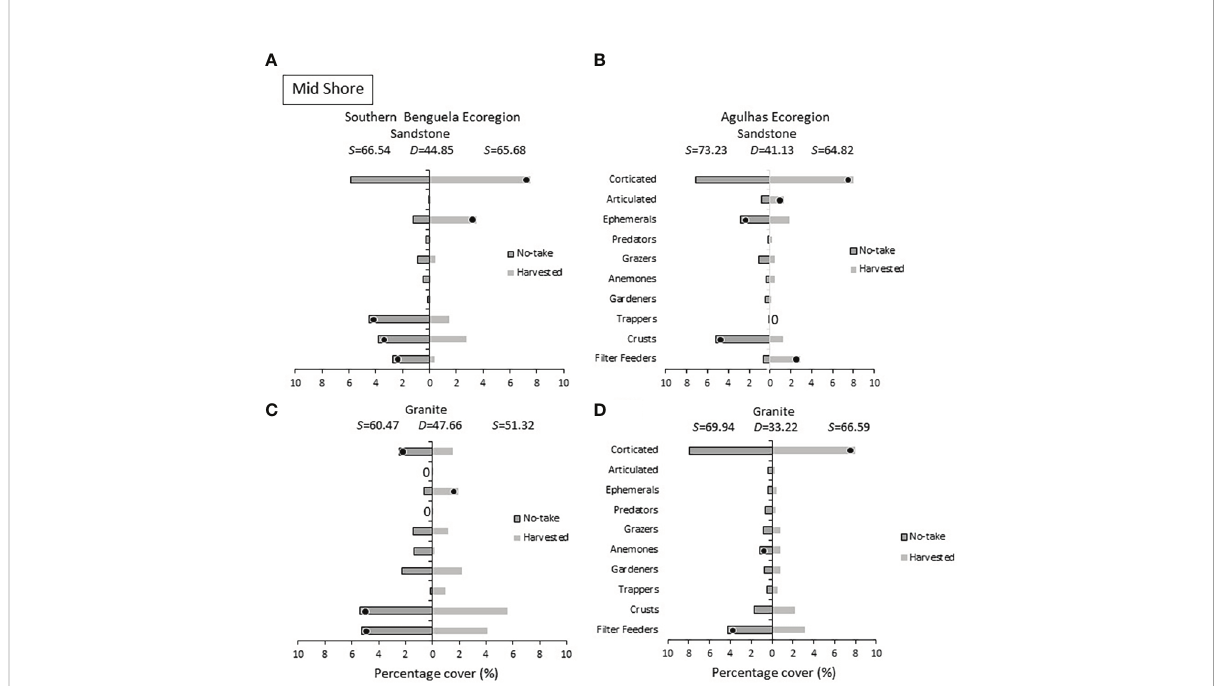
FIGURE 7 Mid shore: Percentage cover of groups responsible for similarities ( S ) within harvested or no-take areas and dissimilarities ( D ) between them, on (A) sandstone in the Southern Benguela and (B) in the Agulhas ecoregions, and on granite in (C) the southern Benguela and (D) Agulhas. See caption for Figure 6 for further